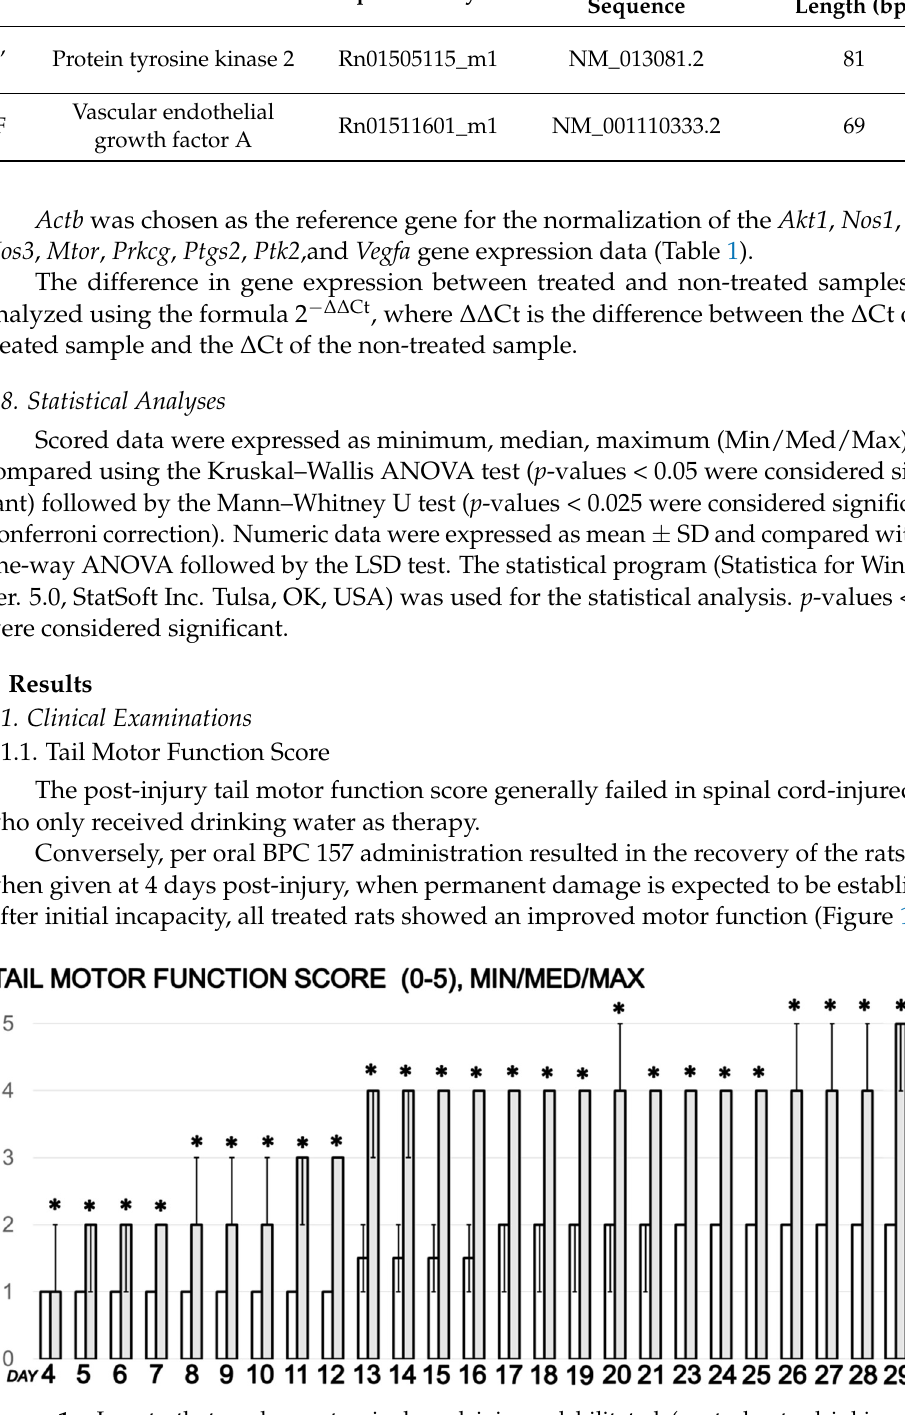
Figure 1. In rats that underwent spinal cord injury, debilitated (control rats drinking water 12 mL/day/rat, white bars) and rescued tail motor function (BPC 157 (10 µ g/kg) in drinking water since post-injury day 4, grey bars) presented by tail motor function score, Min/Med/Max. * p < 0.05, at least, vs.